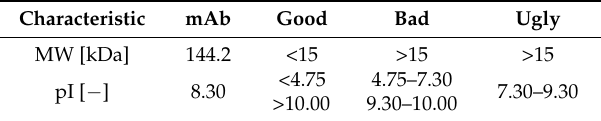
Table 5. Classification of the “Good, Bad, and Ugly” HCP in comparison to the physicochemical properties of the monoclonal antibody (mAb). MW, molecular weight; pI, isoelectric point.